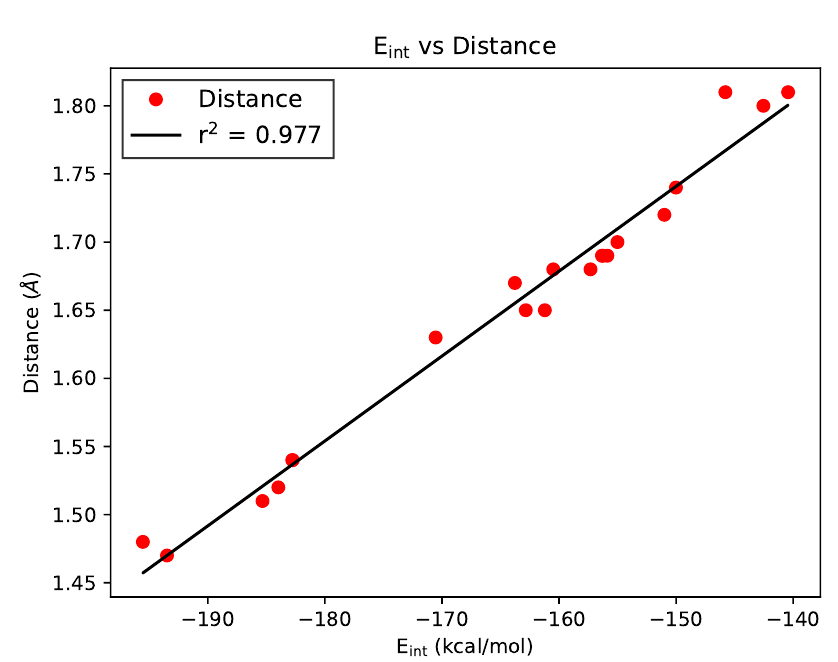
Figure 2. Correlation between IQA interaction energies in kcal/mol and OH ··· H distances in angstroms. Table 1. IQA interaction energies ( E int ), as well as its classical ( V cl ) and exchange-correlation ( V xc ) parts, for the investigated O ··· H RAHB contacts with respect to those in malondialdehyde (Table S1). The values are reported in kcal · mol − 1 . R 1 R 2 R